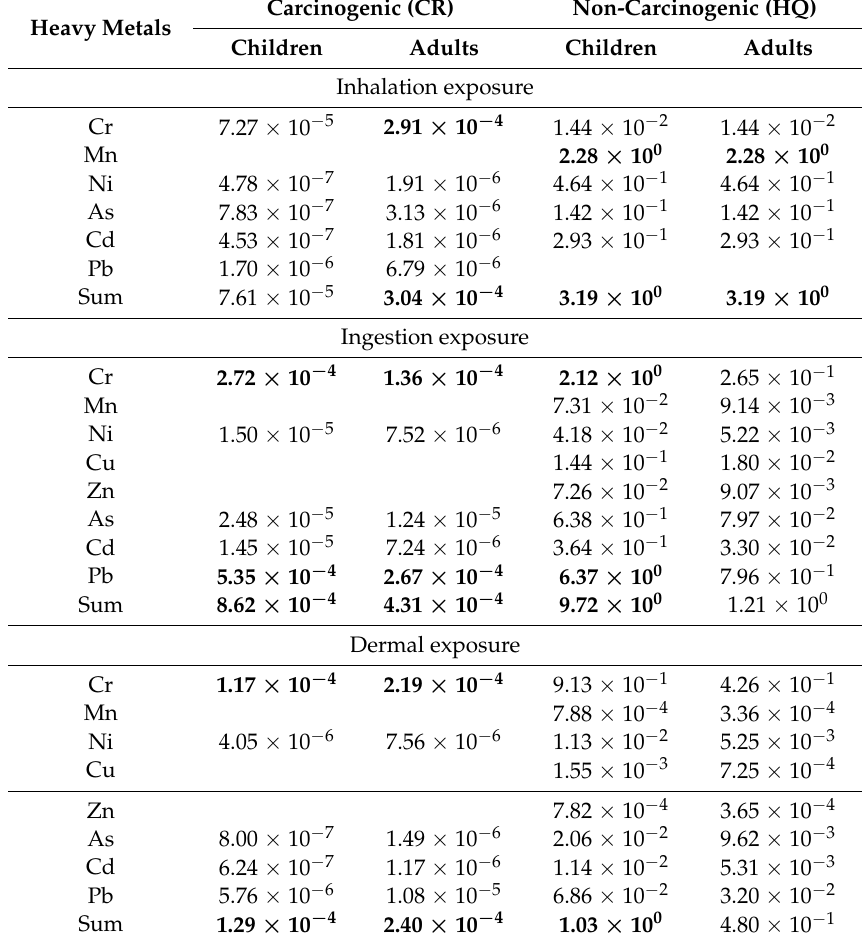
Table 5. Carcinogenic and non-carcinogenic risks of each element for children and adults via inhalation, ingestion, and dermal